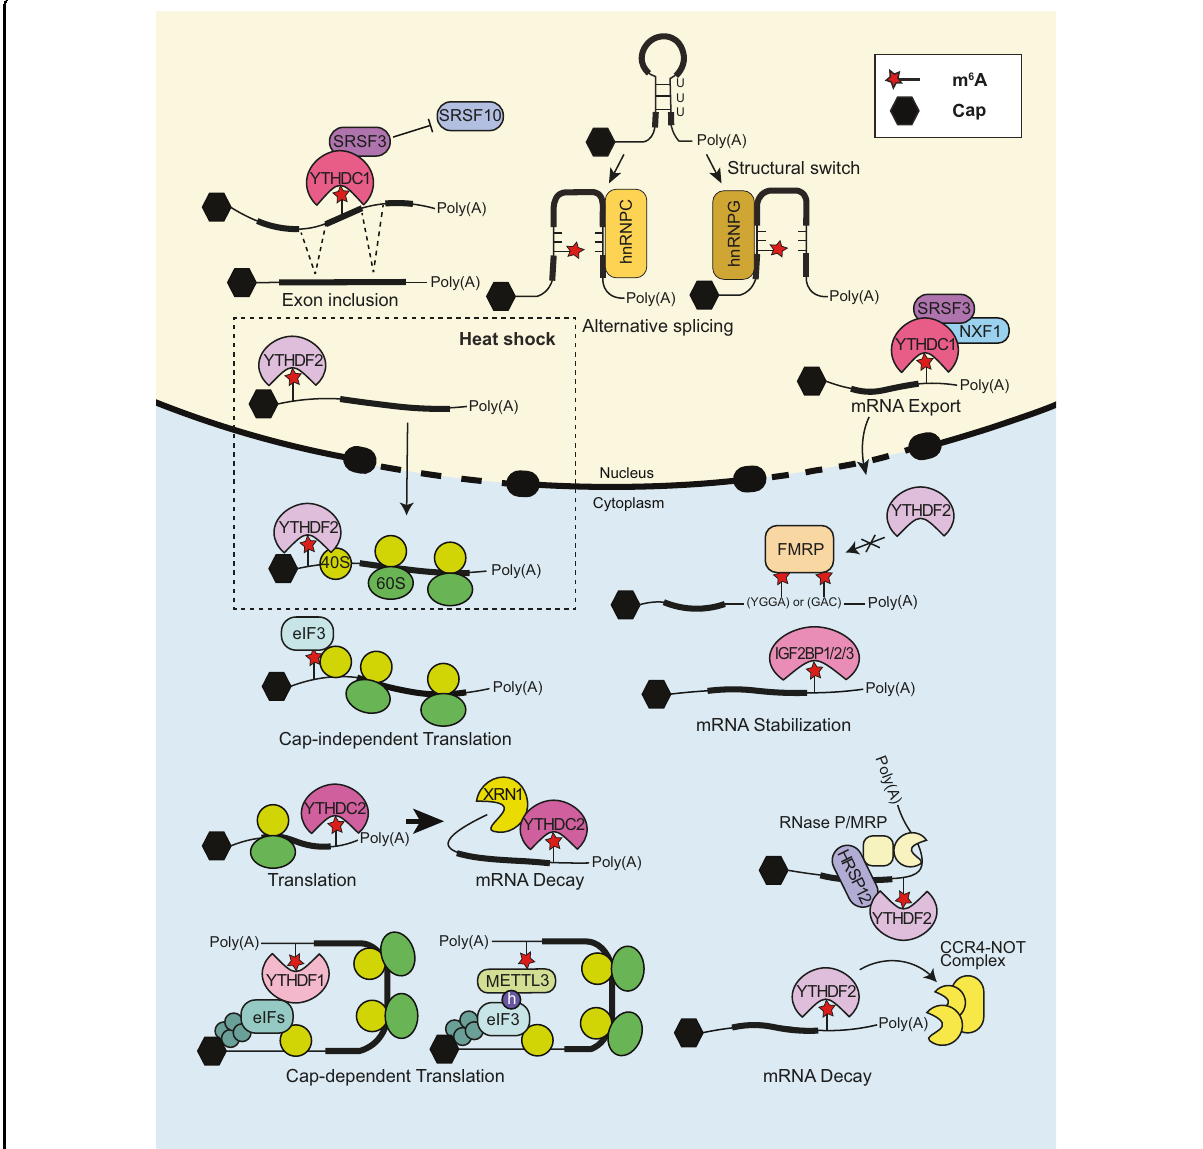
Fig. 2 Molecular details for m 6 A-mediated mRNA metabolism. Multiple m 6 A reader proteins dynamically regulate m 6 A-containing mRNA metabolism, including alternative splicing, mRNA export, structural switch, translation, and mRNA stability, depending on the speci fi c m 6 A-bound reader protein. The thick line represents the coding sequence, and the thin line represents the UTR. The dashed box indicates the heat shock